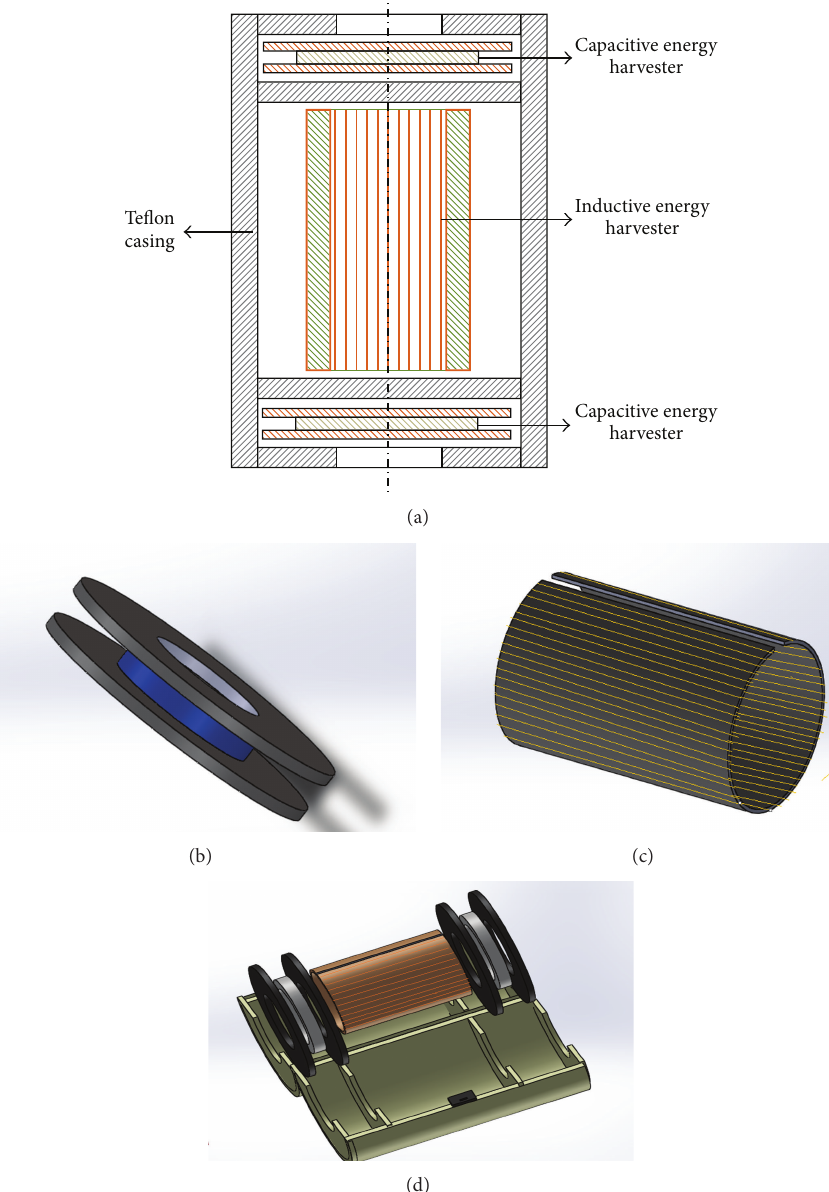
Figure 1: Schematic of the electrodynamic energy harvester: (a) cross-sectional view of the harvester, (b) schematic of the harvester’s capacitive unit, (c) schematic of the harvester’s inductive unit, and (d) exploded view of the harvester with the Teflon